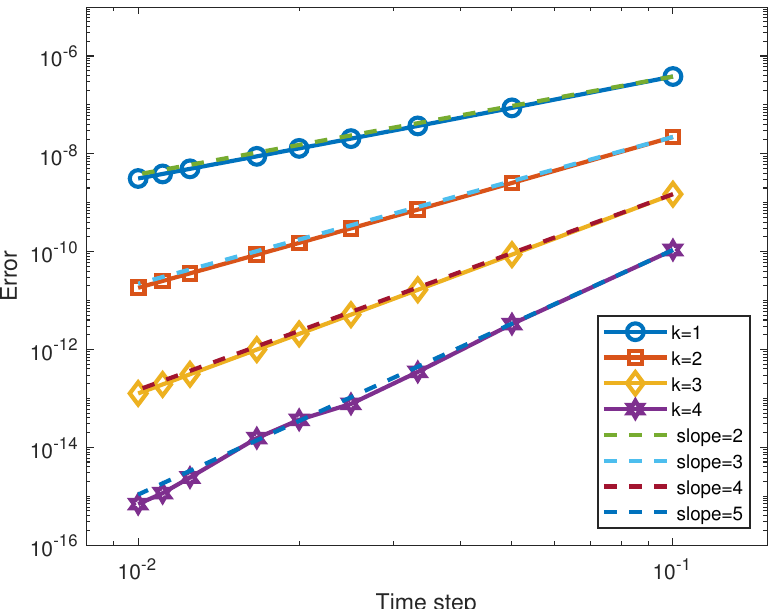
Figure 2. Errors of k -step exponential Rosenbrock multistep method for problem (23). k = 1,2,3,4. D = σ = a = b = c = 1.